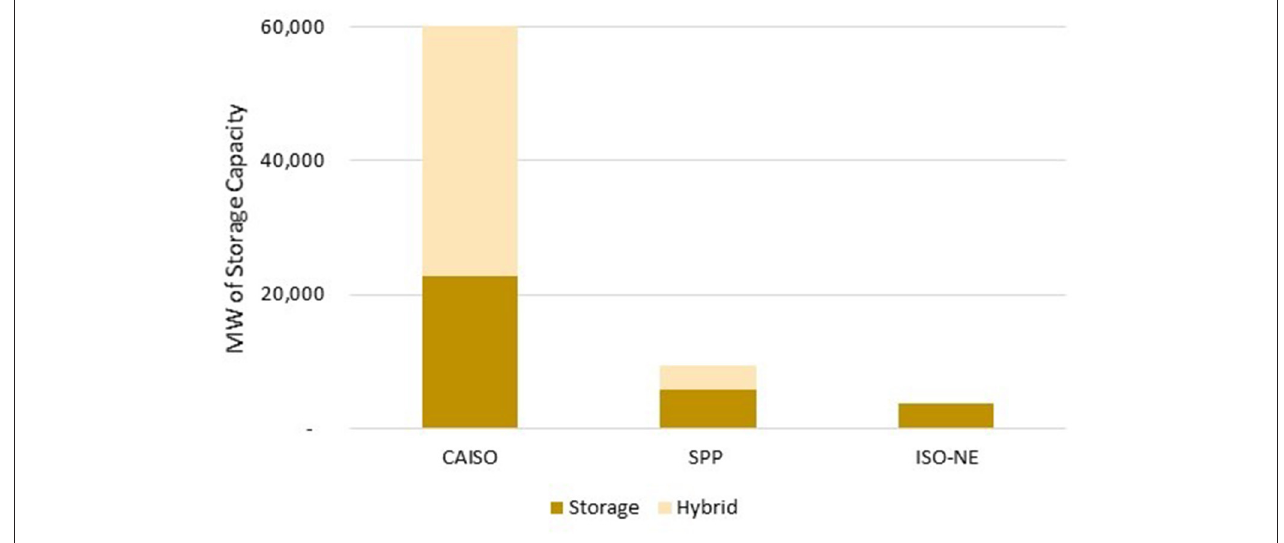
FIGURE 4 | Storage and hybrid (with storage) projects seeking transmission interconnections as of end of 2020. Source: Rand et al.